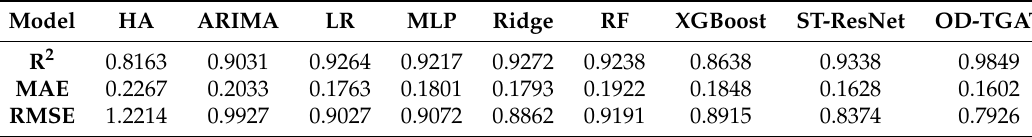
Table 2. Performance Comparison with Baseline